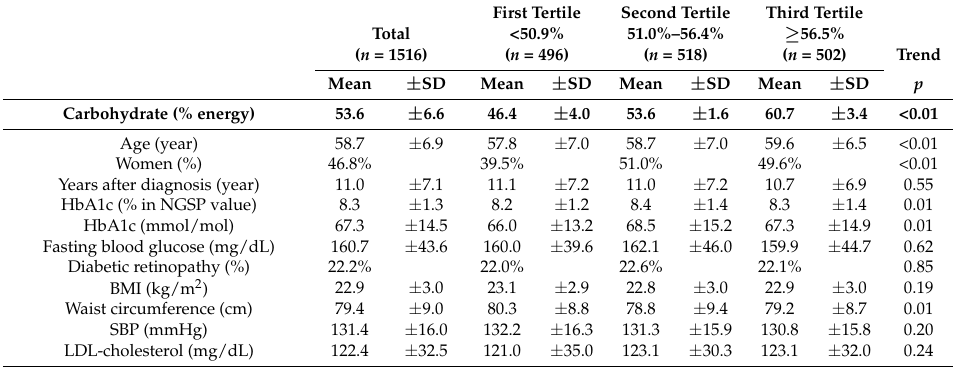
Table 1. Baseline clinical characteristics of the 1516 patients with type 2 diabetes according to proportion of carbohydrate